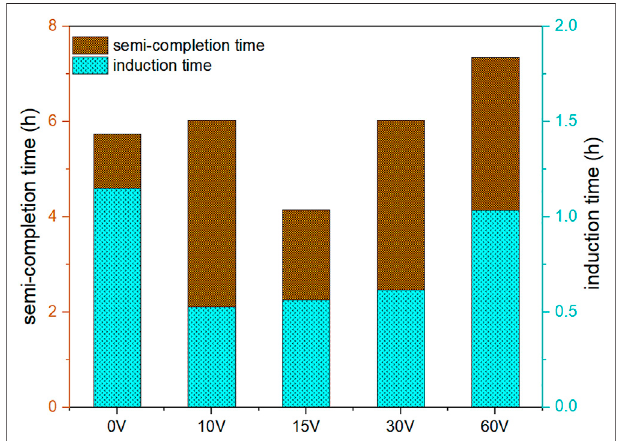
FIGURE 6 | Effect of different voltages on induction time and semi- completion time of CO 2 hydrate at 3.5 MPa and 274.15 K.